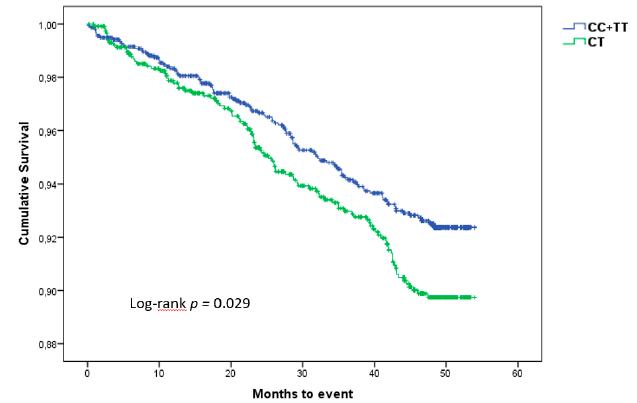
Figure 2. Kaplan–Meier curves showing the difference in the incidence of cardiovascular events according to genotype, during the follow-up period.